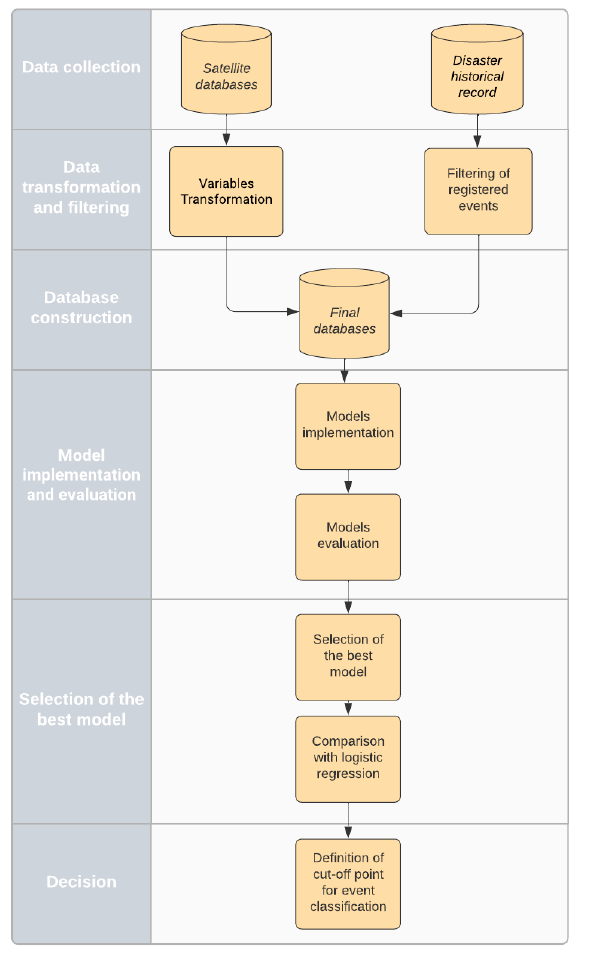
Figure 3. Project M = methodology